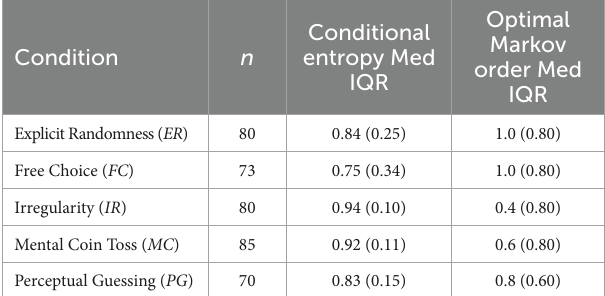
TABLE 3 Median (Med) and interquartile range (IQR) of conditional entropy values and optimal Markov orders per condition.